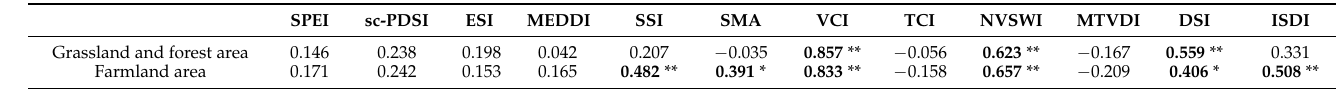
Table 3. Correlation coefficients of drought index and NPP in the grassland and forest area, and farmland area, over 2000 − 2020.